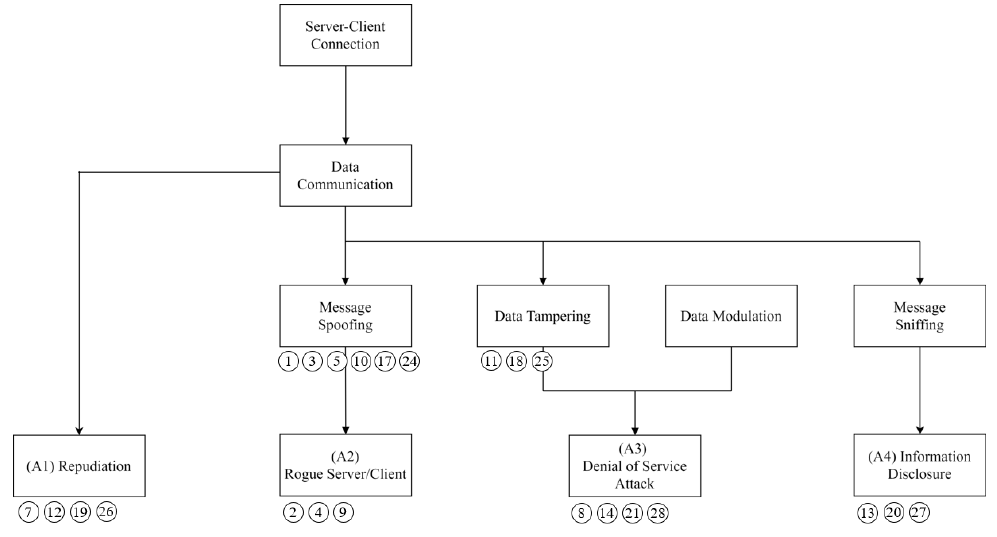
Figure 12. Derived attack tree.